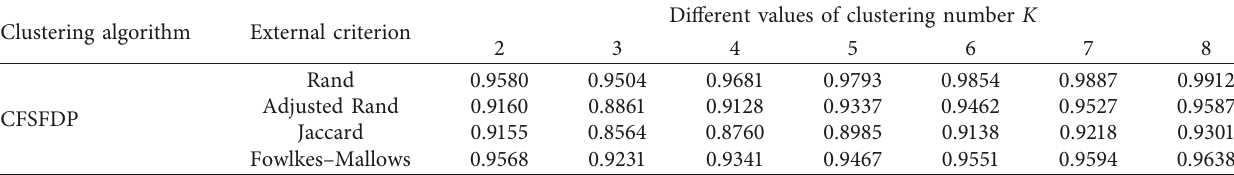
Table 6: CFSFDP clustering analysis with external